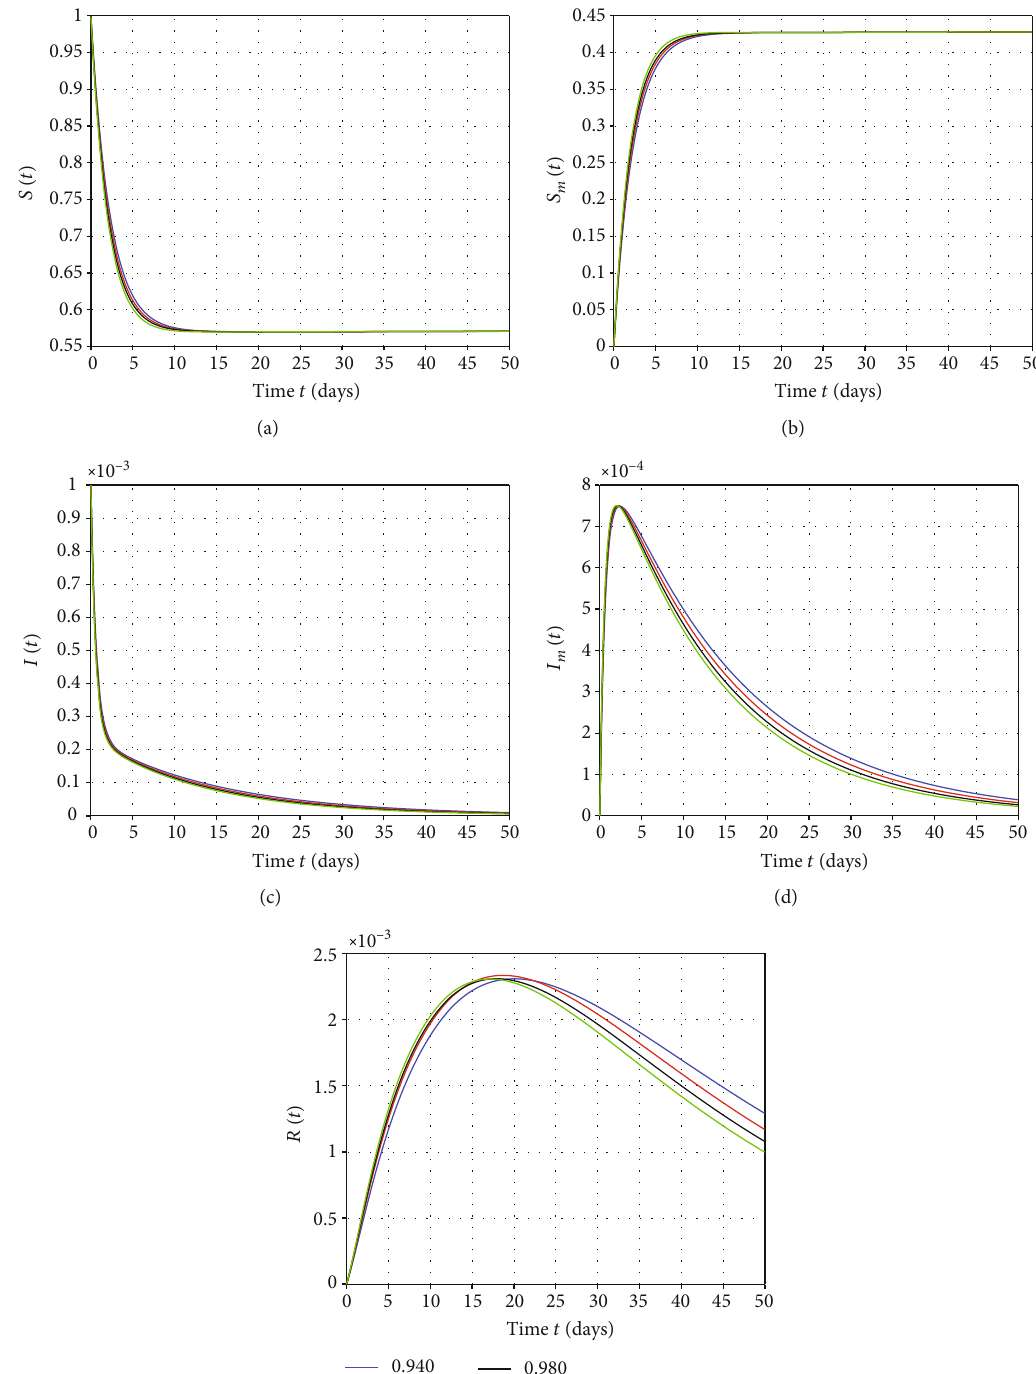
Figure 2: Numerical solution of (10) for κ = 0 : 3 and di ff erent values of ϵ fractional